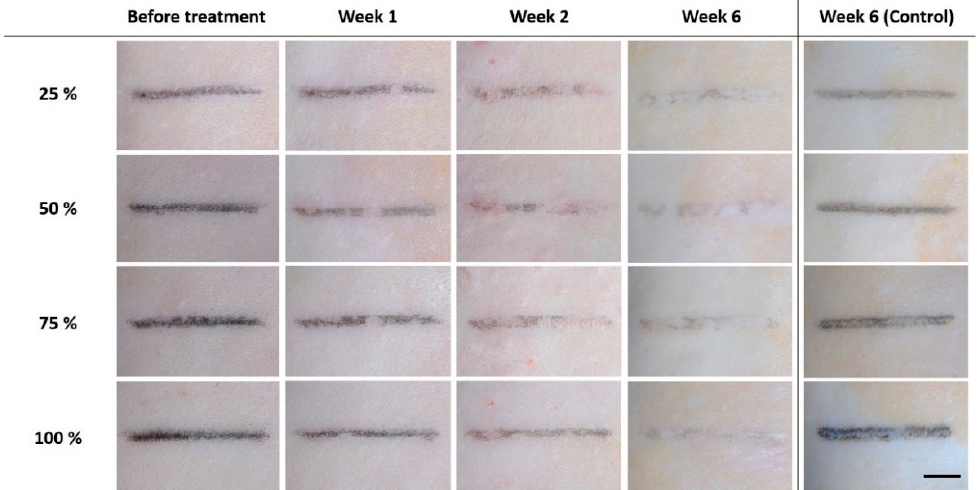
Figure 2. Top surface images of tattoo on skin before (week 0) and after weekly laser treatment (weeks 1, 2, and 6). The far-right column shows images of non-treated tattoo surfaces acquired at week 6 (control; scale bar = 5 mm).